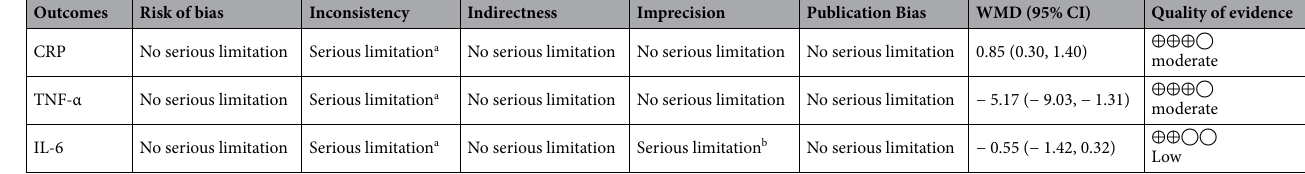
Table 5. GRADE profile of vitamin A supplementation for CRP, TNF-α, and IL-6. Grading of Recommendations Assessment, Development, and Evaluation (GRADE) of vitamin A supplementation for CRP, CRP C-reactive protein, IL-6 IL-6 interleukin 6, TNF-α tumour necrosis factor-α. a There is significant heterogeneity for CRP (I 2 = 96.2%), TNF-α (I 2 = 98.5%), and IL-6 (77.8%). b There is no evidence of significant effects of vitamin A supplementation on IL-6 (confidence interval includes